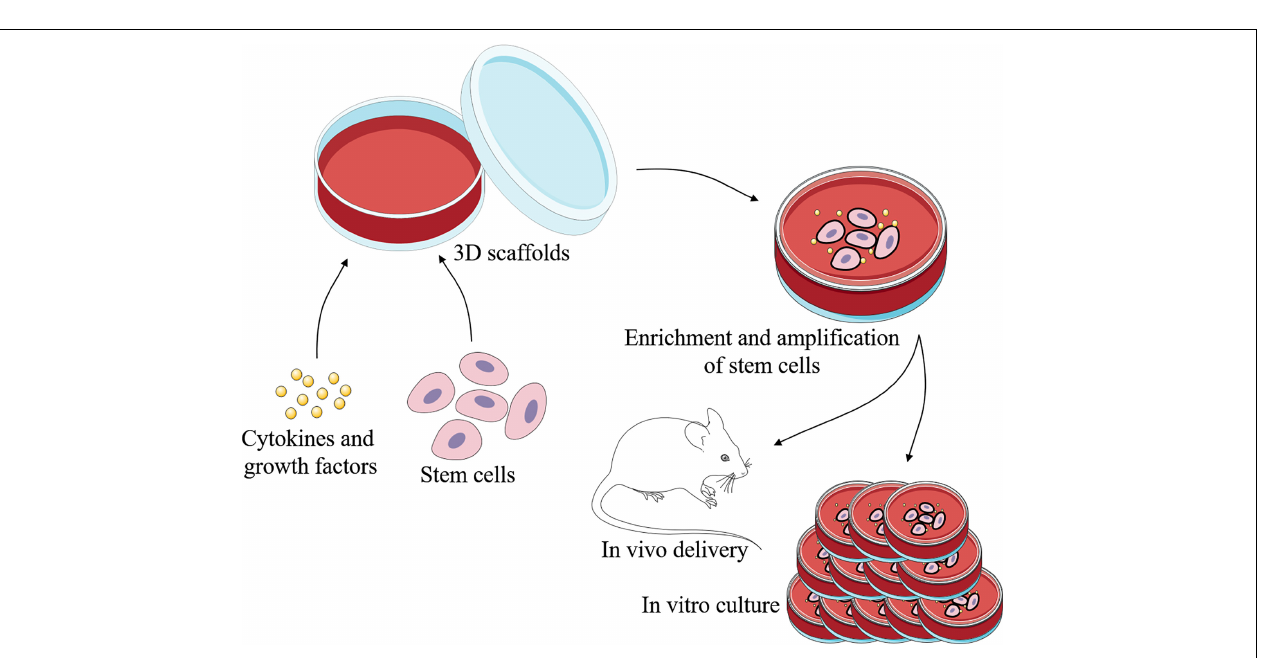
Frontiers in Cell and Developmental Biology | www.frontiersin.org